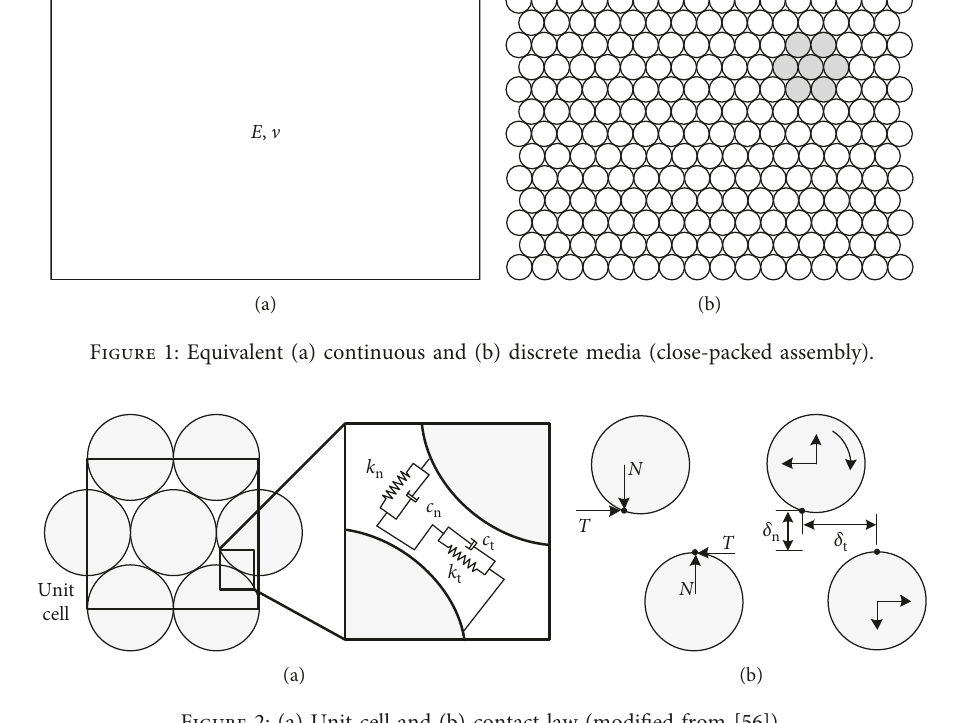
Figure 2: (a) Unit cell and (b) contact law (modified from